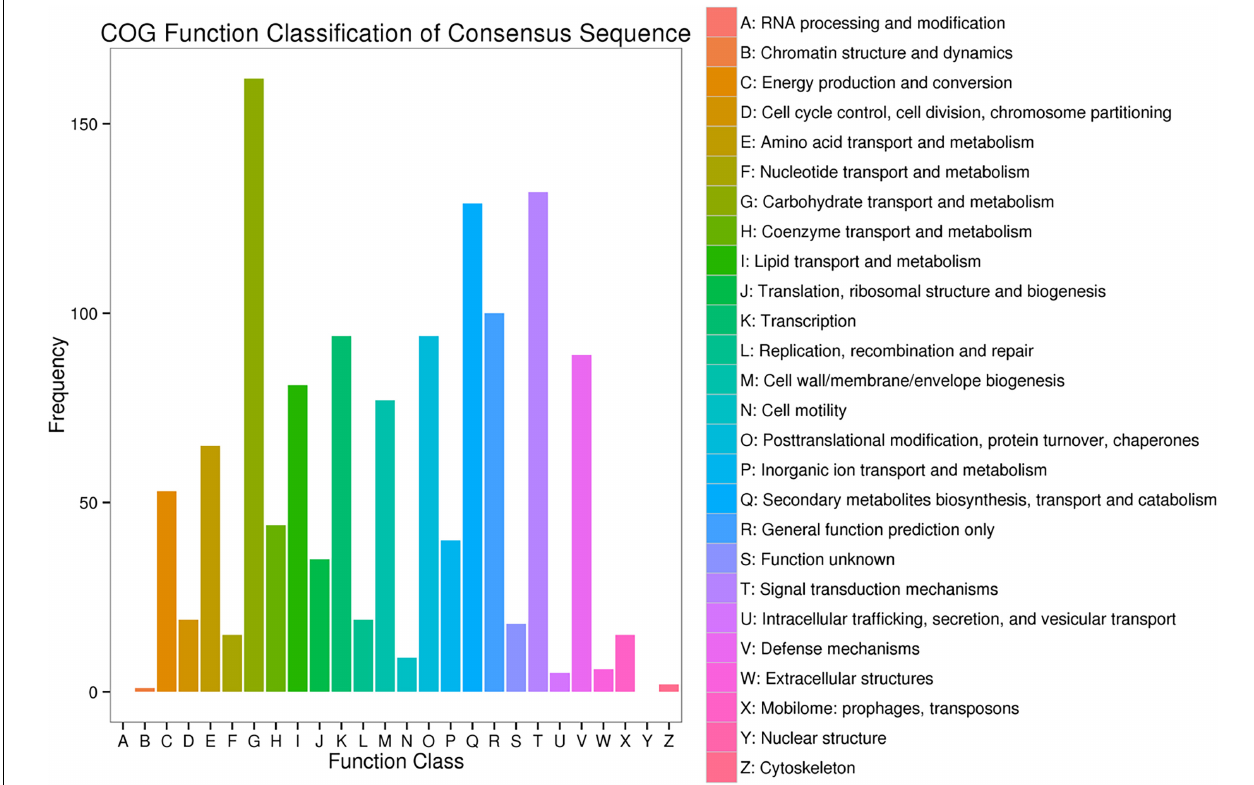
FIGURE 7 | Clusters of orthologous groups (COG) analysis of the DEGs with consistent differences between the resistance and susceptible parents YD588 and YN21 and their derived resistance and susceptible bulks from their derived F 2 : 3